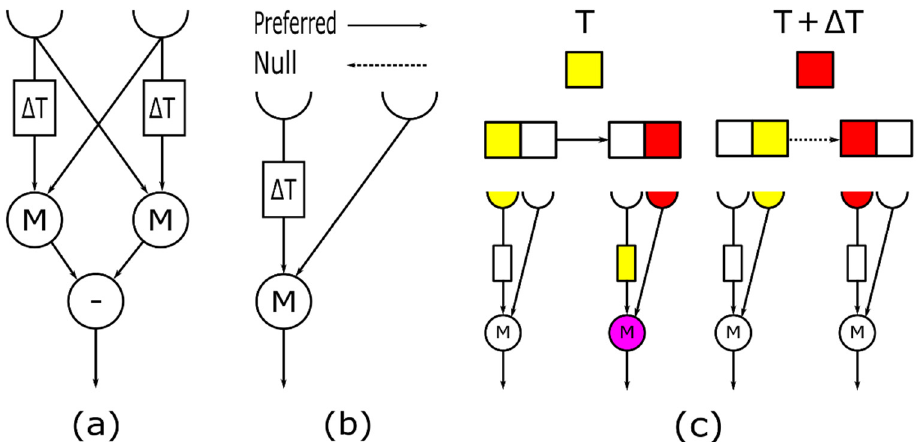
Figure 1. ( a ) Schematic of the HRC model. ( b ) Schematic of the rightwards motion detector of the HRC model. ( c ) Process of the rightward motion detector in detecting its preferred direction (left) and null direction (right). In its preferred direction, the activation signal caused by the light spot at time T (yellow) will be delayed until time T + ∆ T and then multiply with the activation signal caused by the light spot at time T + ∆ T (red); thus, the rightward motion detector will respond (pink). Conversely, the rightwards motion detector will evoke no response in its null direction detection because the signal from the receptor at time T has not been temporally delayed.